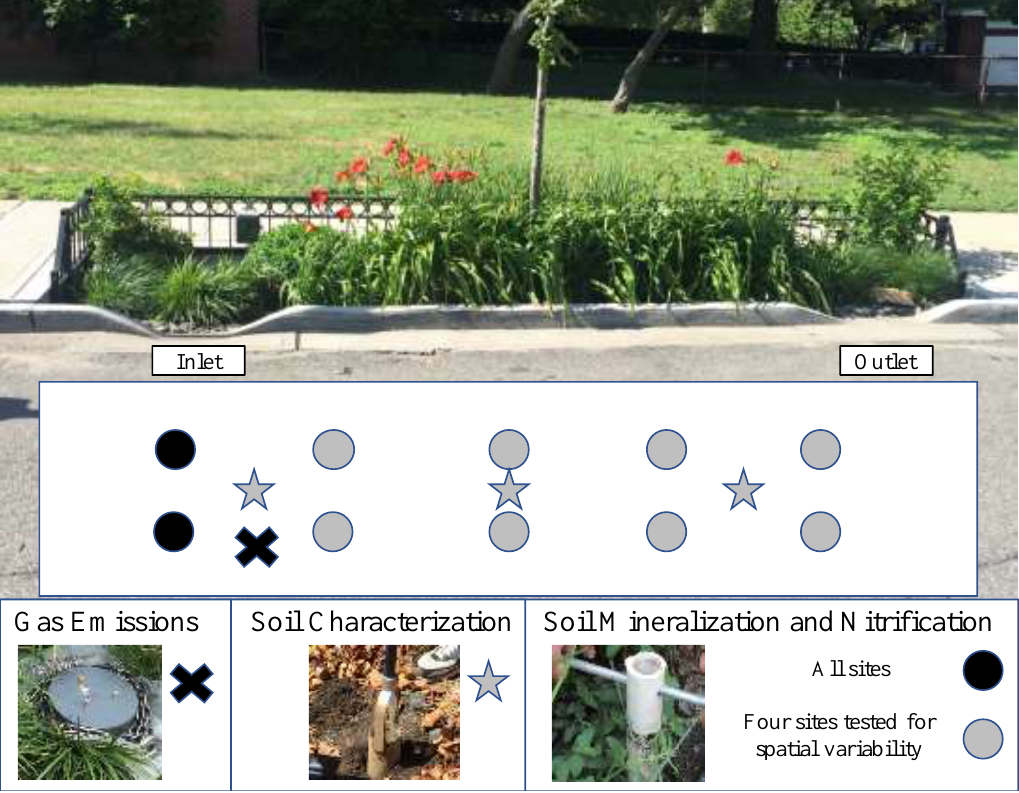
Figure 2. Photo of representative site with example sampling strategy. Plant sampling locations are omitted from the figure because all plant species were sampled throughout each site.